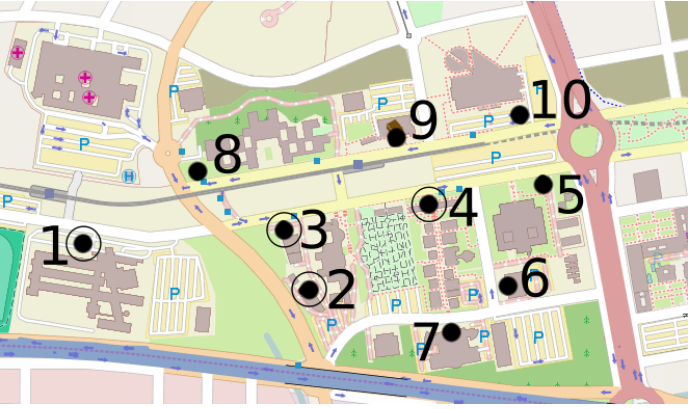
Figure 4. Location of the sensors installed in the Campus of